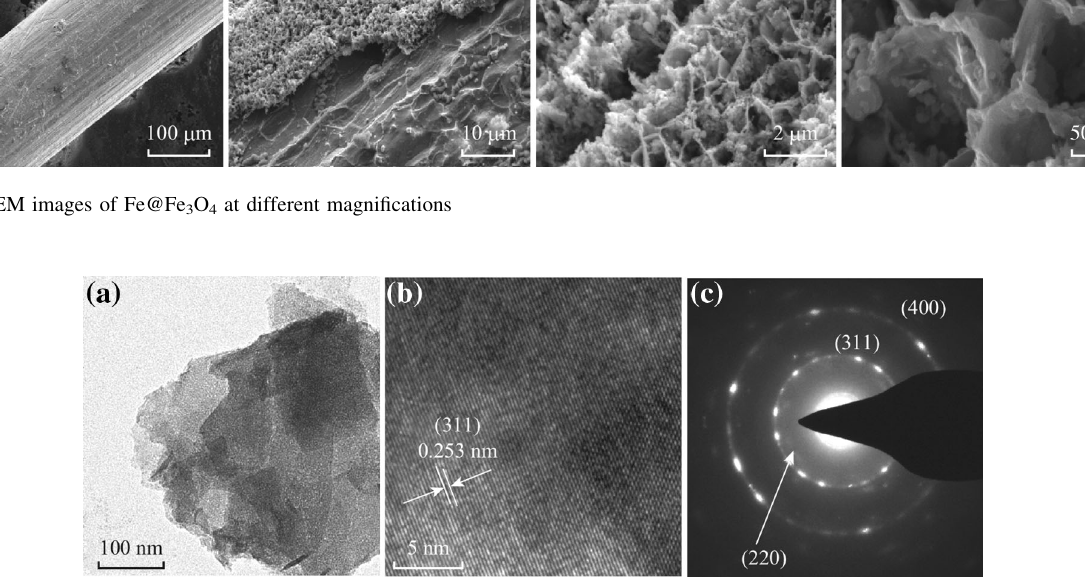
Fig. 2 a TEM and b HRTEM images of the Fe 3 O 4 . c The SAED pattern of the Fe 3 O 4 (carefully scratched from Fe@Fe 3 O 4 )